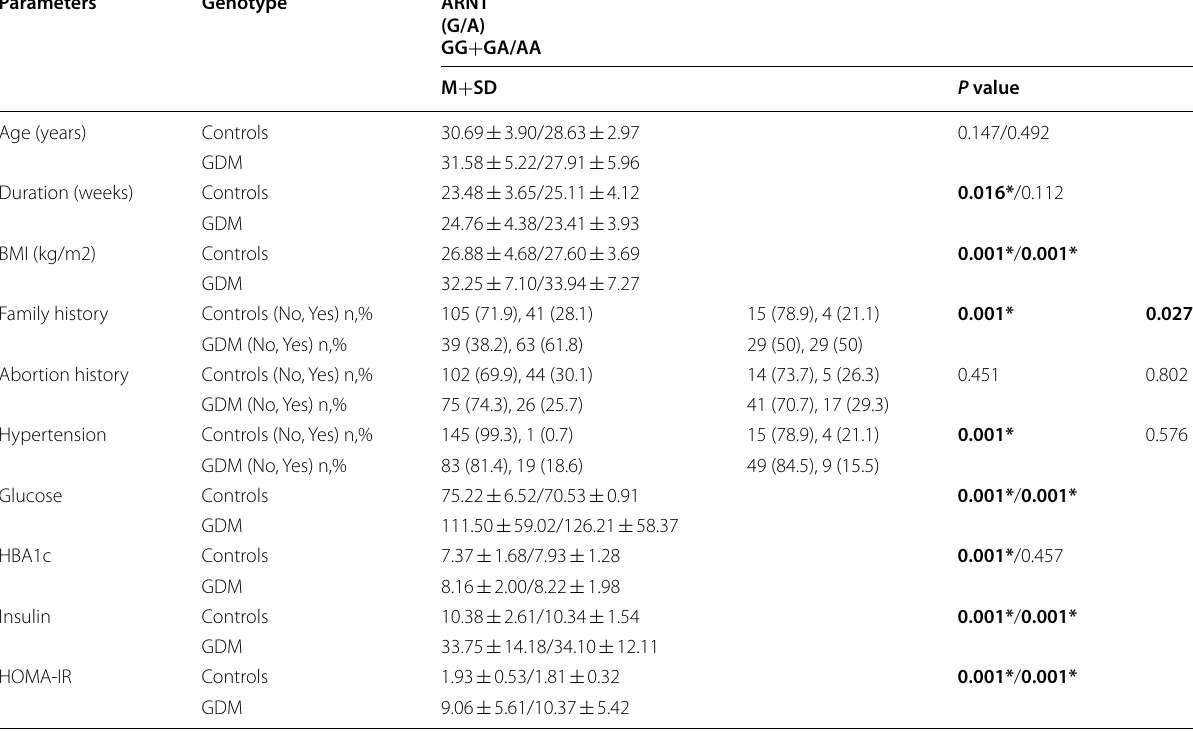
Table 4 Relation between different genotypes of the ARNT (G/A) and risk factors among GDM and controls